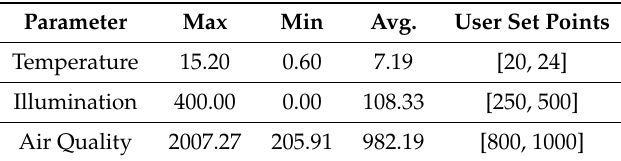
Figure 4. Collected hourly data along with user set points for 31 days (744 h). Table 2. Data summary with user set